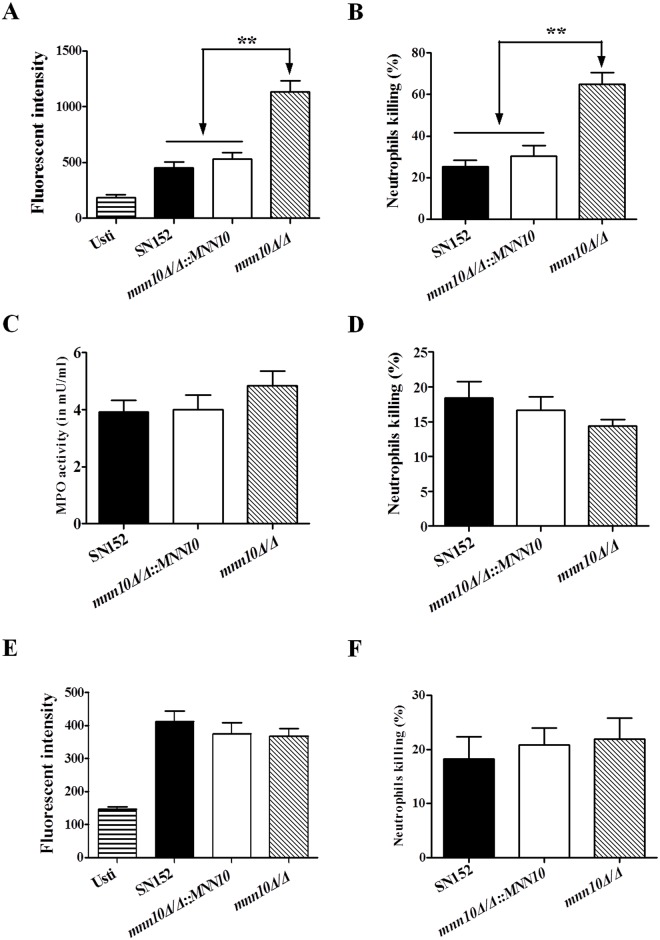
Neutrophils killed mnn10 mutant more efficiently with an augmented respiratory burst.(A, E) Neutrophils respiratory burst assay. The cellular reactive oxygen species production of thioglycollate-elicited peritoneal neutrophils were measured after incubation with C. albicans for 1 h (MOI = 1) with (E) or without (A) 2 mM ascorbic acid. (B, D) Neutrophils killing assay. Neutrophils (6×105 cells) were incubated with 3×104 CFU viable C. albicans for 1 h with (D) or without (B) 2 mM ascorbic acid. Then the suspension was plated on SDA agar for 48 h to count live C. albicans colonies. (C) Neutrophils were incubated with the indicated C. albicans for 1 h (MOI = 1). The cellular level of MPO in neutrophils was measured after incubation with C. albicans. (F) Neutrophils (6×105 cells) were incubated with 3×104 CFU C. albicans hyphae for 1 h. Then the suspension was plated on SDA agar to count live C. albicans colonies. Data shown are means ± SD of triplicates from one representative experiment of three. Usti, unstimulated. **, P < 0.01 (One-way ANOVA with Bonferroni post-test).